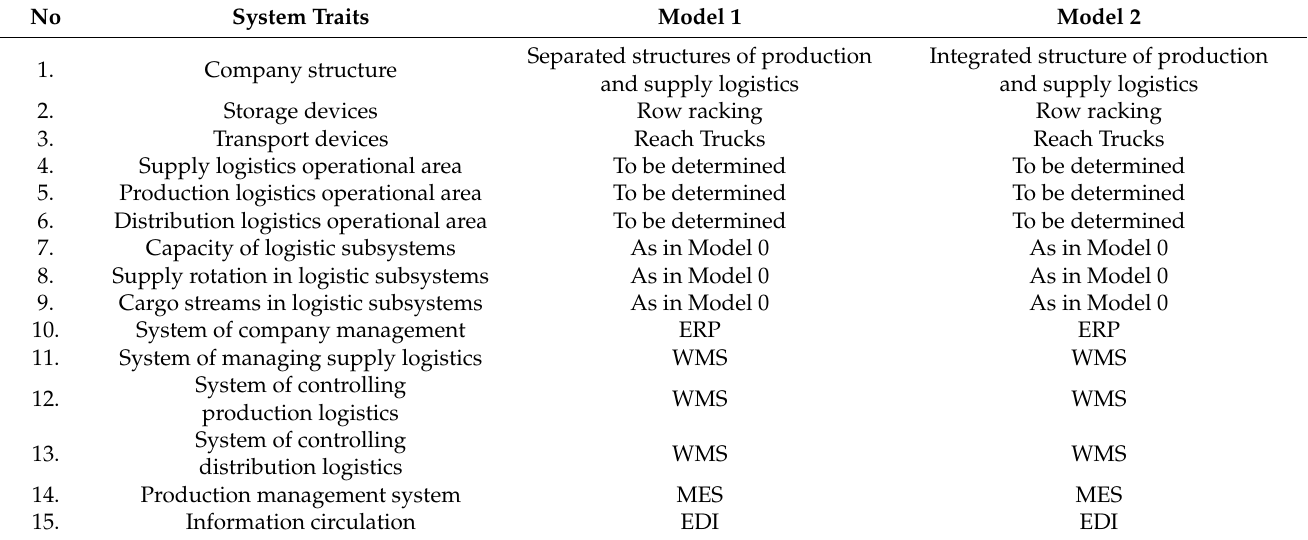
Table 5. Logistics system features in Model 1 and Model